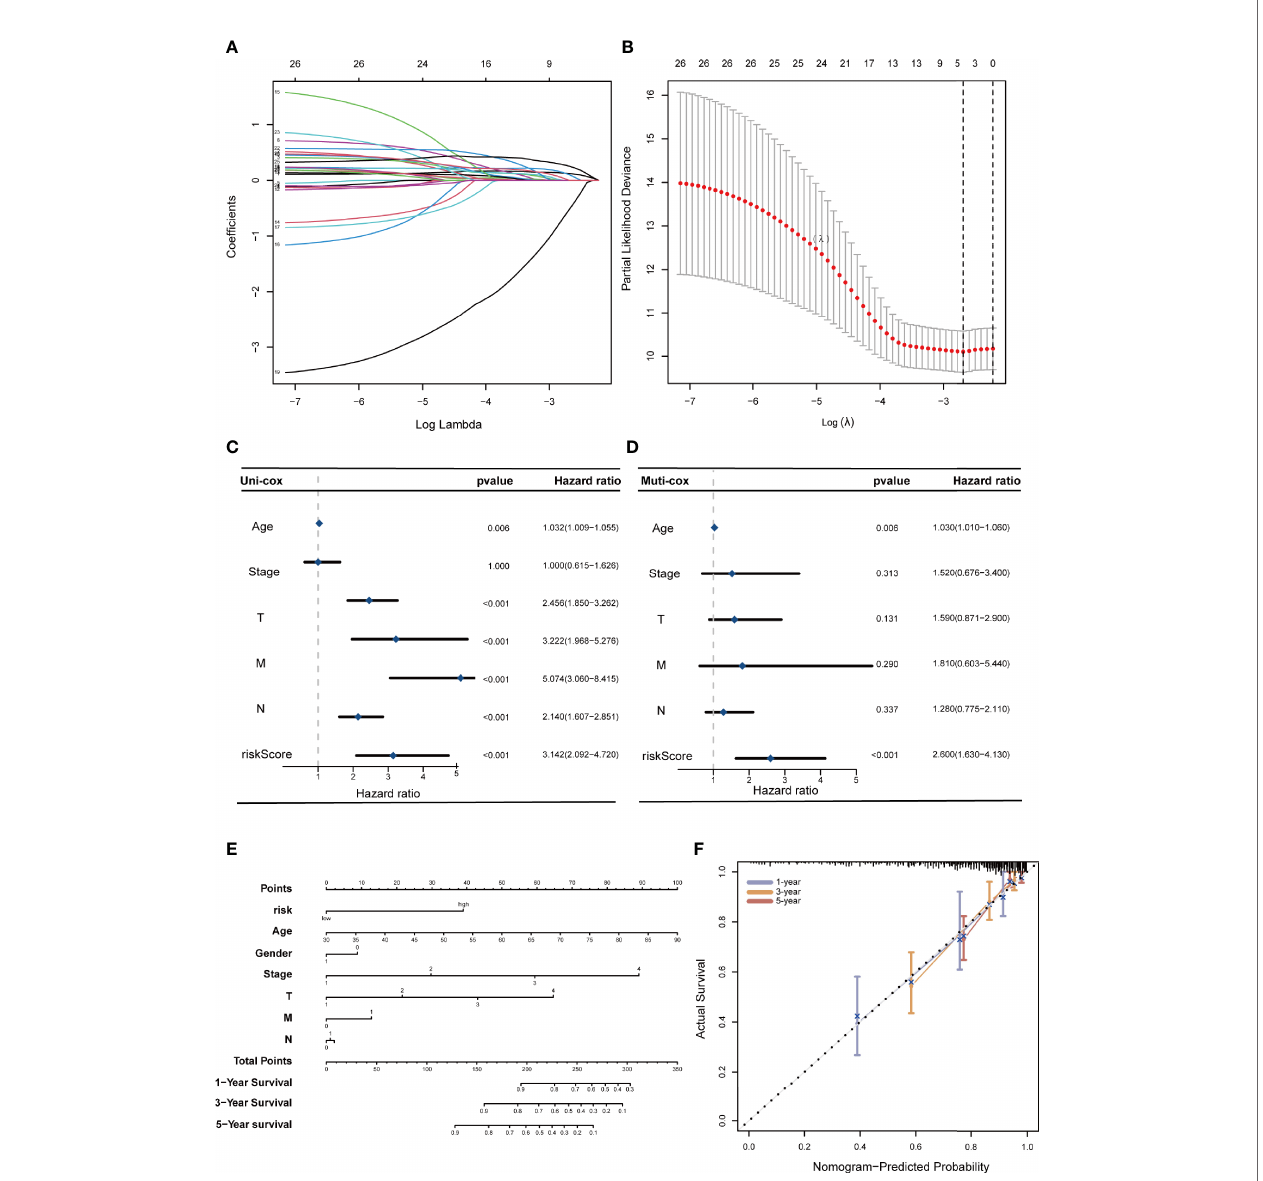
FIGURE 3 | Construction of a 4-ferroptosis-related-lncRNA signature and the analysis of independent prognostic potential. (A, B) cv fi t and lambda curves showing the least absolute shrinkage and selection operator (LASSO) regression was performed with the minimum criteria. (C, D) Results of the univariate Cox regression analysis and multivariate Cox regression analysis regarding OS of the 4-ferroptosis-related-lncRNAs signature. (E) The nomogram to predict the 1-year, 3-year, and 5-year overall survival rate of colon cancer patients. (F) The calibration curve for evaluating the accuracy of the nomogram model. The dashed diagonal line in grey colour represents the ideal